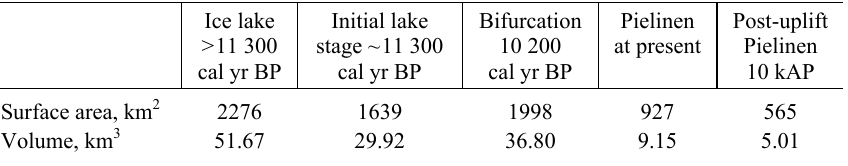
Table 1. Changes in the surface area and water volume of Lake Pielinen during its post-glacial development. 10 kAP = 10 000 years after present Ice